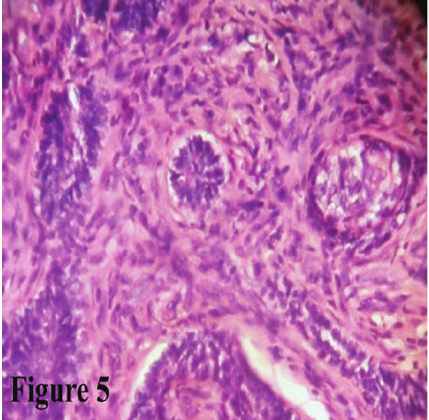
Figure 5: H and E-stained section shows ameloblastic follicles with acanthomatous changes (40 ×